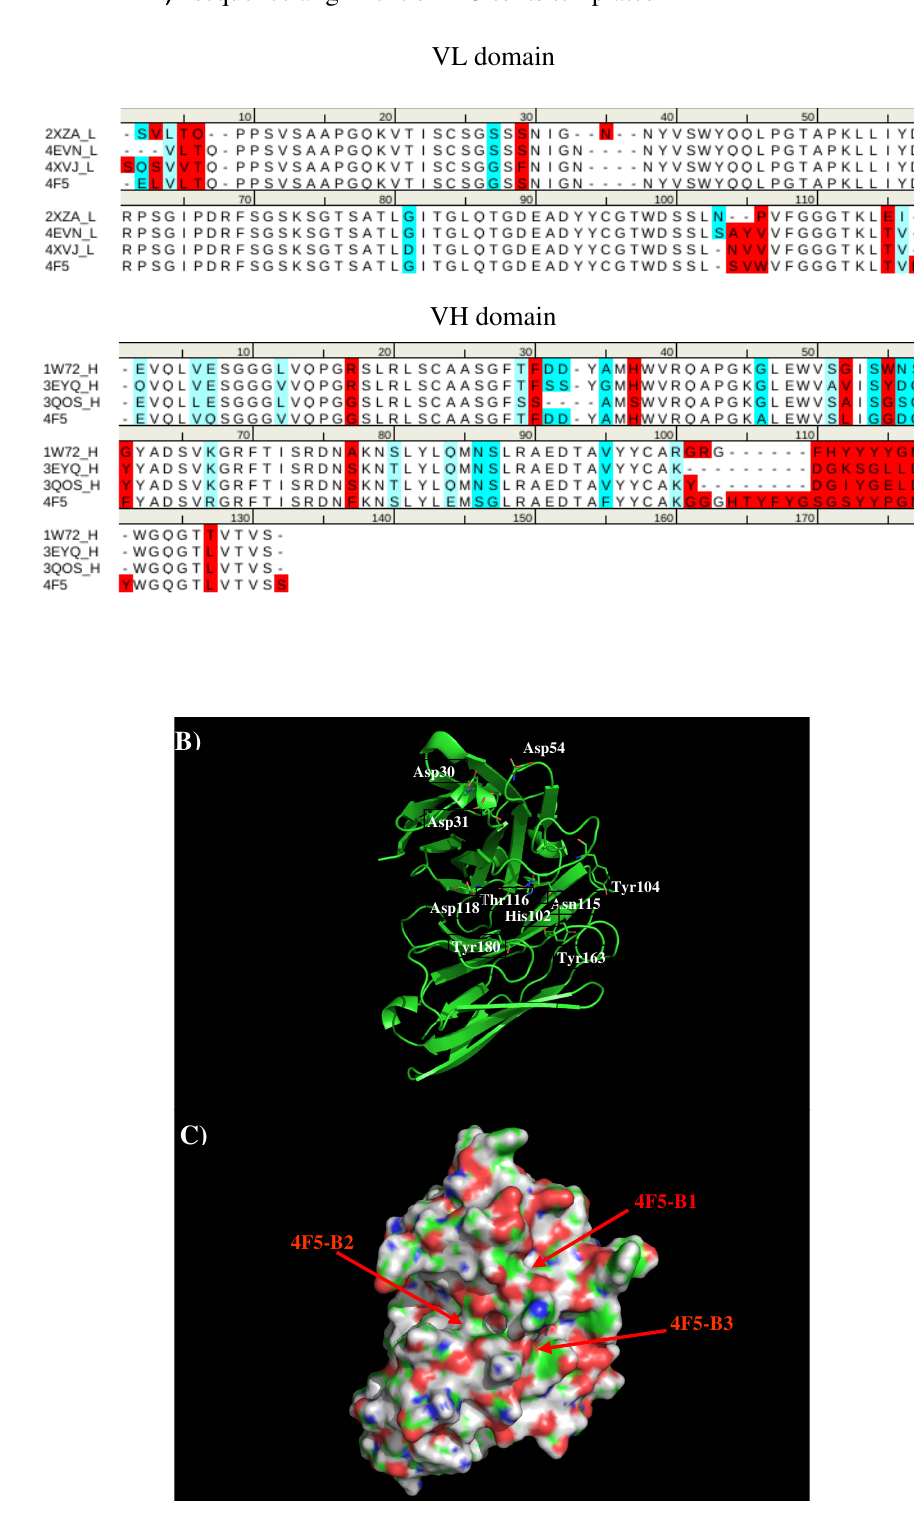
Figure 10. ( A ) Sequence alignment of VL domain of 4F5 to its templates 2XZA [34], 4EVN [35], and 4XVJ [36] for VL domain, and VH domain of 4F5 to its templates 1W72 [37], 3EYQ